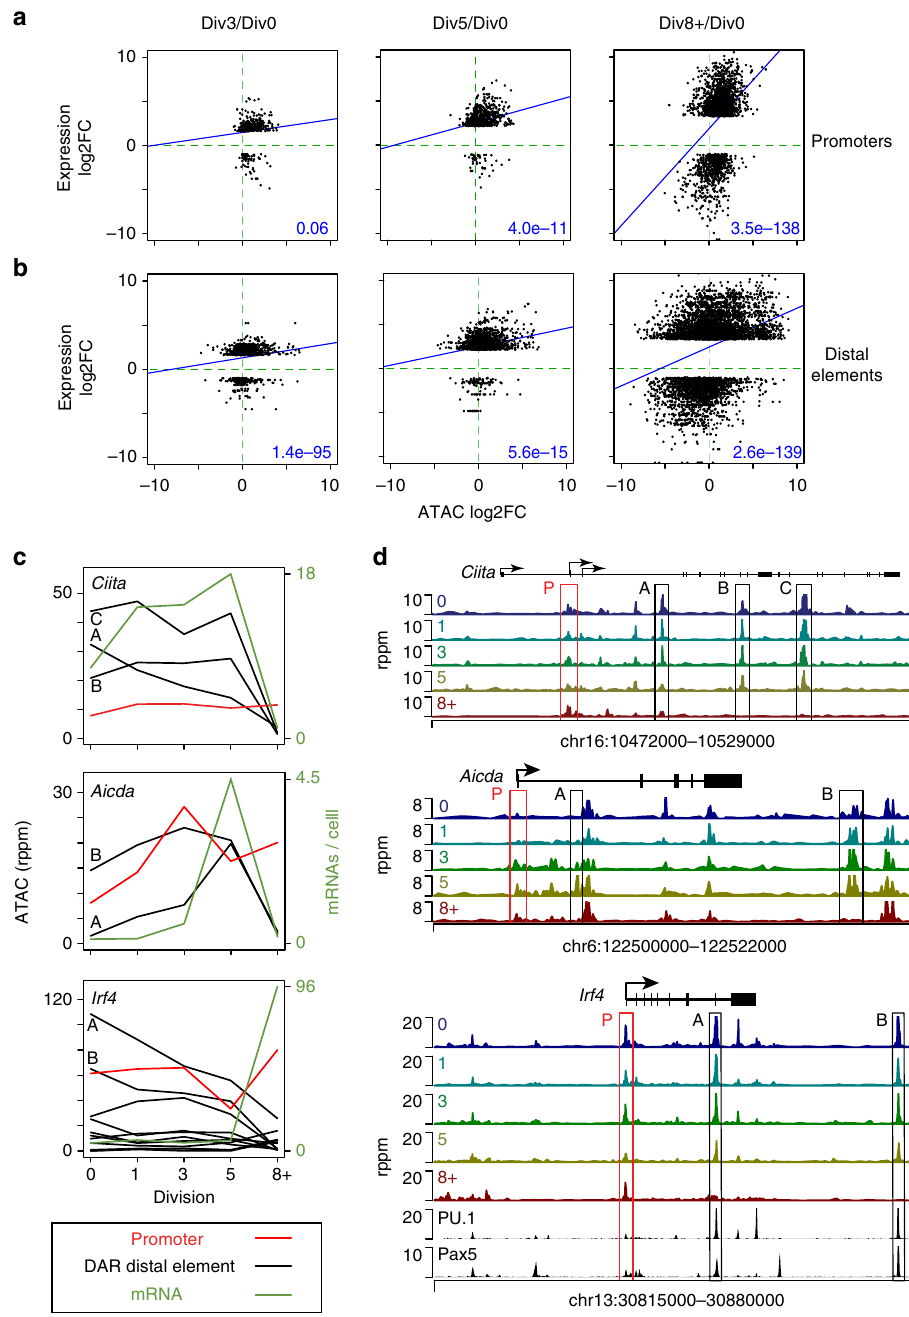
Fig. 4 Coordinated changes in gene expression and distal cis -element accessibility. Gene expression and chromatin accessibility changes between the indicated division comparison for a promoters and b distal elements are shown as scatter plots. The signi fi cance of the linear regression is indicated. c For the indicated gene, the accessibility of all distal element DAR (black line) and the promoter (red line) are plotted with respect to each division. Overlaid on the data is the mRNA expression pro fi le (green) for the same cellular divisions. d ATAC-seq accessibility pro fi le for each gene plotted in c . For Irf4 , previously reported B cell data for PU.1 35 and Pax5 36 are plotted. rppm, reads per peak per